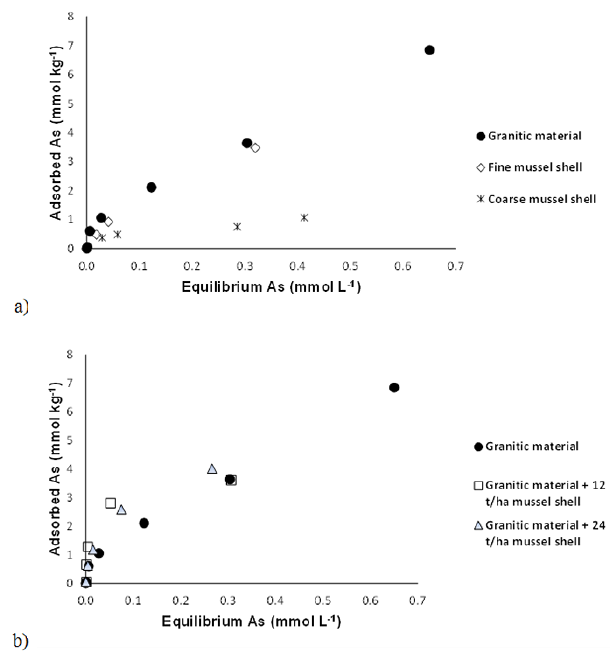
Figure 1. Adsorption curves for the individual materials (a) and for the unamended and shell-amended (12 or 24tha − 1 ) granitic ma- terial (b) . Average values of three replicates, with coefficients of variation always <